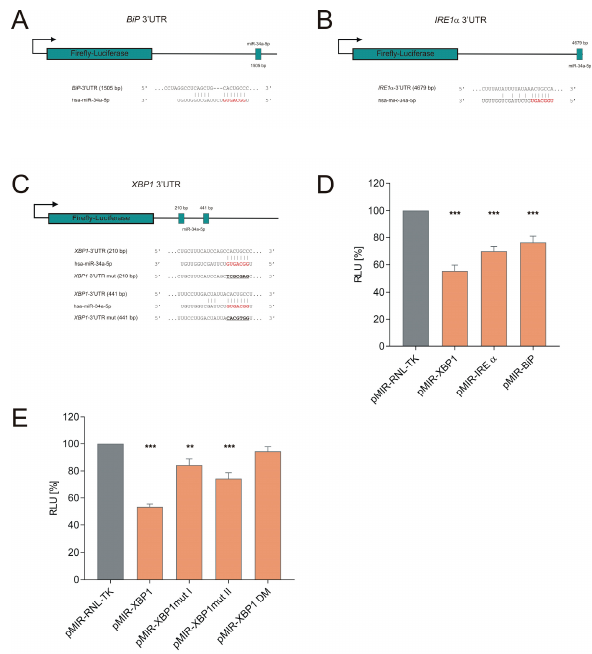
Figure 2. miR-34a targets the IRE1 α branch of the UPR. ( A – C ) Schematic overview of BIP ( A ), IRE1 α ( B ) and XBP1 ( C ) 3 (cid:48) UTRs with miR-34a-5p binding sites. 3 (cid:48) UTR sequences of BIP , IRE1 α and XBP1 were cloned into pMIR-RNL-TK reporter plasmids. The locations of the miR-34a-5p-predicted binding sites are shown schematically in the 3 (cid:48) UTR of the target genes as well as in the sequence of the 3 (cid:48) UTR (red). Sequences that are mutated to replace the miR-34a-5p binding site are underlined. ( D ) Dual-luciferase reporter assays for BIP , IRE1 α and XBP1 . HEK293T cells were transfected with reporter gene construct as well as a miR-34a expression plasmid in the indicated combinations. Luciferase activity was measured 48 h post transfection. The RLUs were normalized to the RLU received with the empty pMIR-RNL-TK reporter plasmid co-transfected with a miR-34a expression plasmid. ( E ) Mutagenesis assay for XBP1 . HEK293T cells were transfected with reporter gene constructs for XBP1 with mutated miR-34a binding sites as well as miR-34a expression plasmid. Luciferase activity was measured 48 h post transfection. The RLUs were normalized to the RLU received with the empty pMIR-RNL-TK reporter plasmid co-transfected with miR-34a expression plasmid. The experiments were performed as three biological replicates, each in duplicate. Data represent mean ± SEM (* = p ≤ 0.05, ** = p ≤ 0.01, *** = p ≤